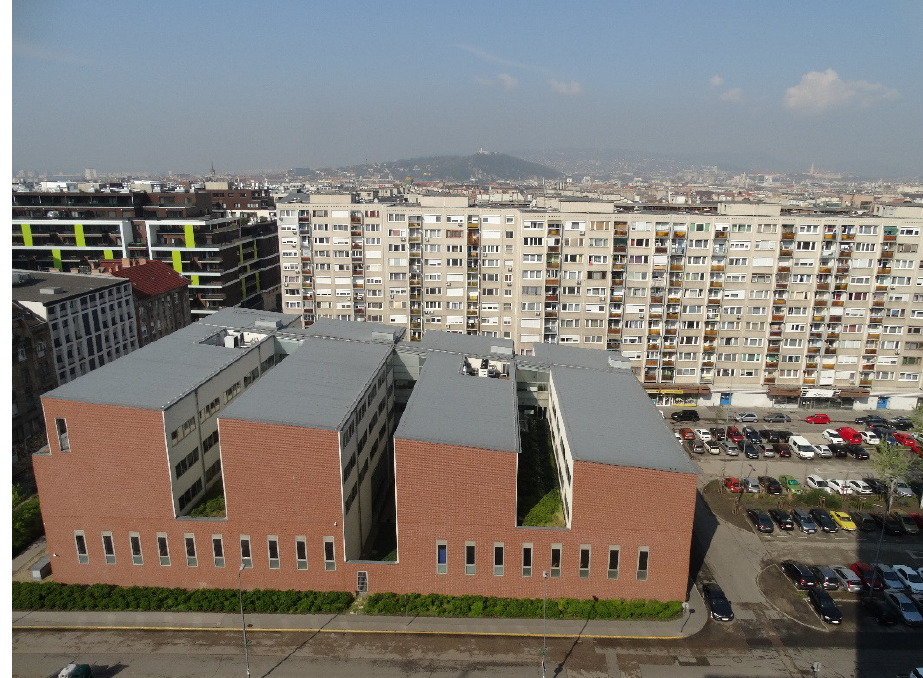
Figure 7. Szigony Street view from a panel building: The contemporary brick university building occupies a part of the planned urban highway between modern slab buildings without any communication with its